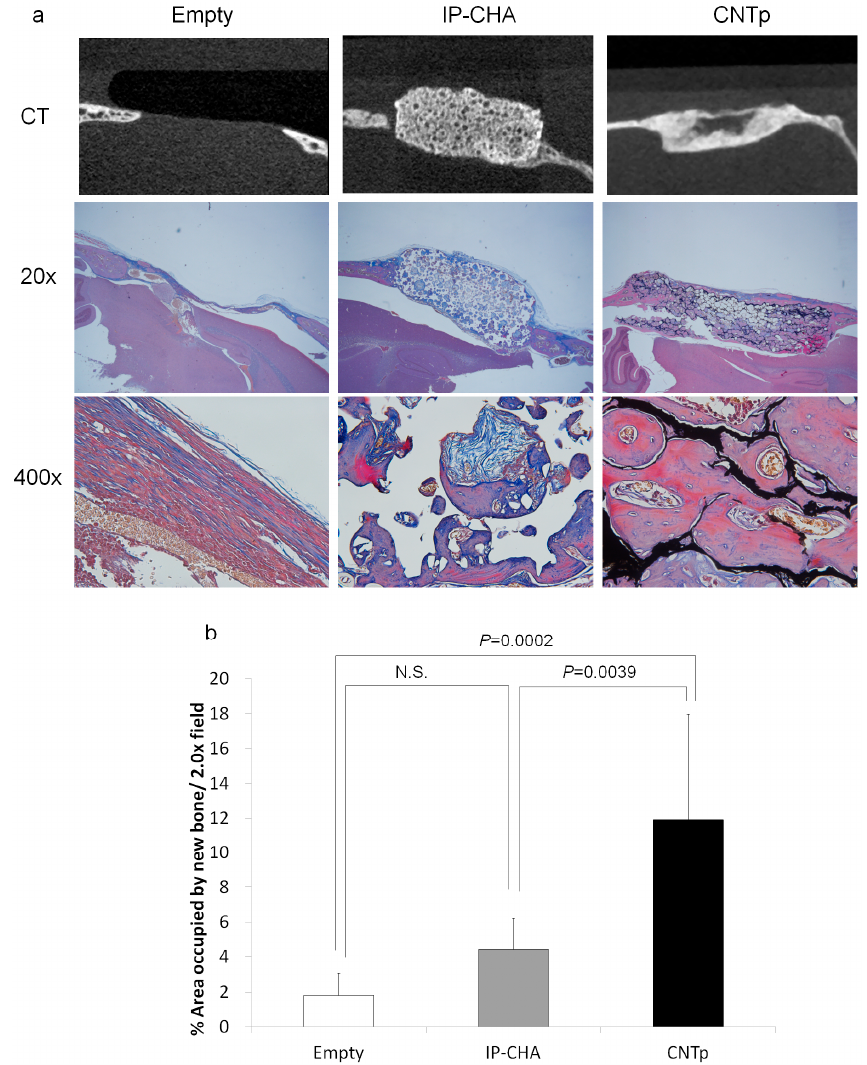
Figure 10. ( a ) Micro-CT and histological image of empty control, IP-CHA, and CNTp scaffold implanted in the calvarial defects of ddY mice for 12 weeks; ( b ) A bar diagram showing the newly formed bone area/20 × field in the calvarial defect of ddY mice implanted with each scaffold for 12 weeks. Mean values were compared using one-way ANOVA followed by Tukey’s post hoc test ( n = 7). N.S.: Not Significant.